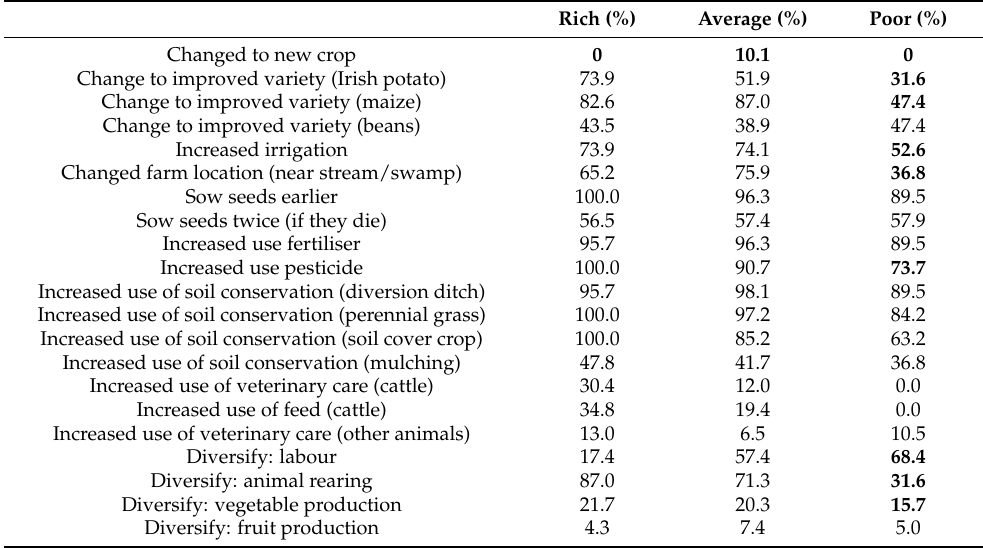
Table 2. Differential adaptation responses by wealth groups by farmers around Kibira, Burundi (n = 150). % refers to the % of respondents within each wealth group. Bold refers to significant differences across wealth groups at p < 0.05, using cross-tabulation tables and chi-square tests.